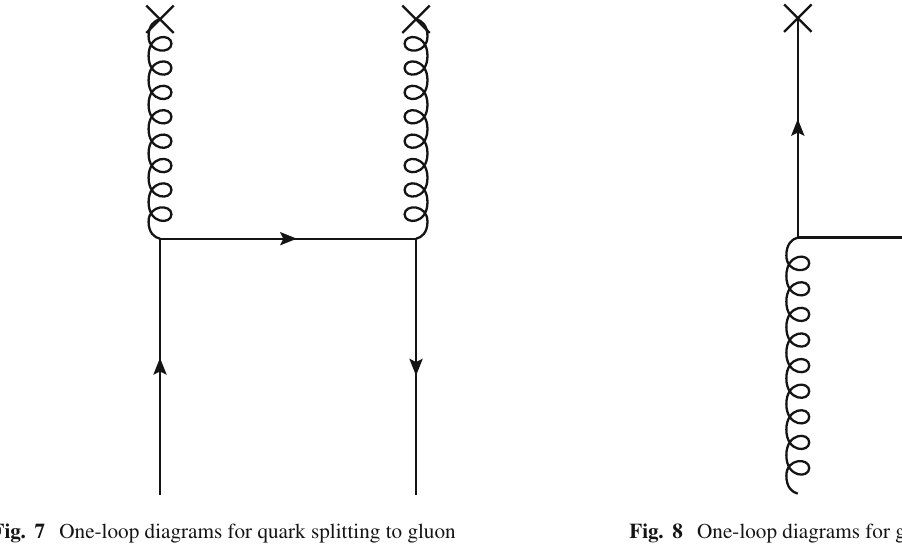
Fig. 8 One-loop diagrams for gluon splitting to